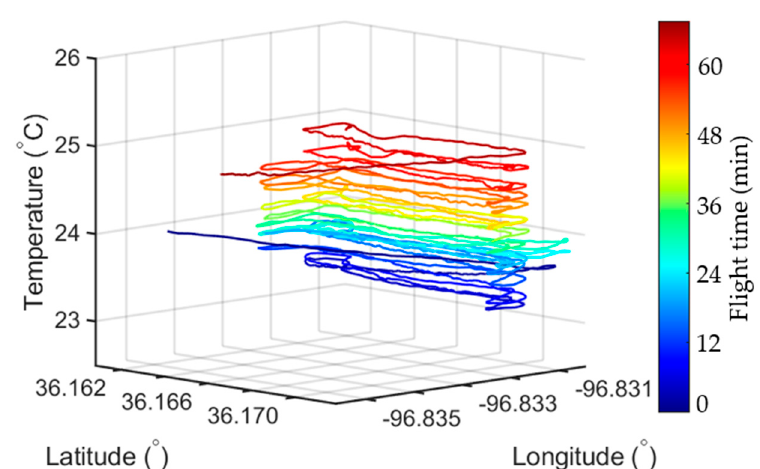
Figure 4. GPS-resolved temperature measurements along the Skywalker X8 flight path at 50 m AGL from 7:06 to 7:57 a.m. (UTC–5 h) on 28 June, 2017. The color bar to the right hand side represents the progression of time from blue in the beginning to red at the end of this latitudinal flight path.